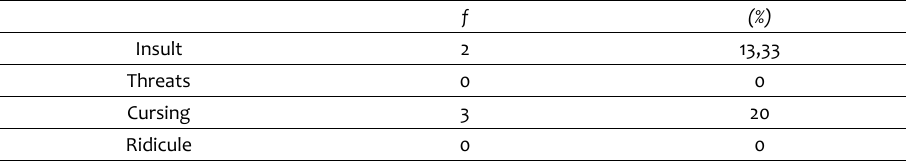
Table 4. Forms of violent communication among peers after the research